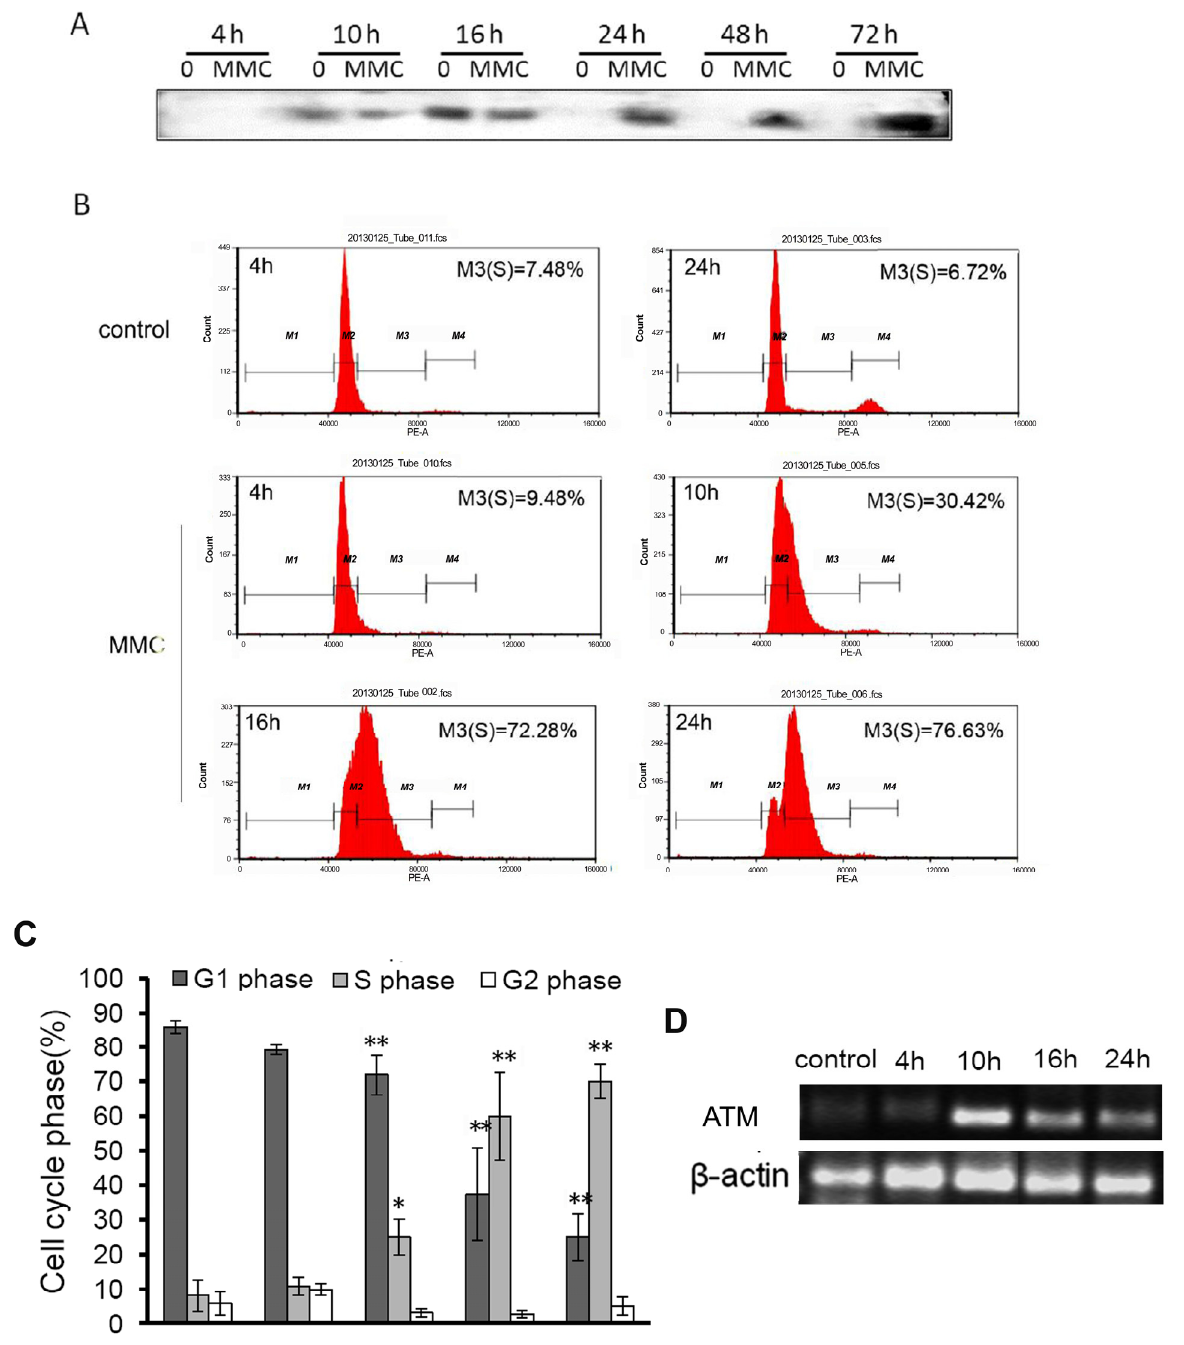
Figure 3. The mechanism of MMC enhancing rAAV-mediated gene expression. ( A ) the effect of MMC on rAAV’s genome by southern blot analysis; ( B ) FACS assay for the S phase arresting after MMC (1000 ng/mL) and AAV- EGFP (2 × 10 5 Gps/cell) co-treatment of U251 cell, only AAV- EGFP treated group as control, and M1–4 represent for sub G1, G1, S and G2 phase respectively; ( C ) Statistical analysis for the effect of MMC (1000 ng/mL) and AAV- EGFP (2 × 10 5 Gps/cell) co-treatment on inducing cell cycle arrested, and cell only treated with same dose of AAV- EGFP or MMC at 24 h as control. (* p < 0.05, ** p < 0.01); and ( D ) RT-PCR analysis for ATM mRNA expression mediated by MMC and AAV- EGFP (2 × 10 5 Gps/cell) co-treatment in U251